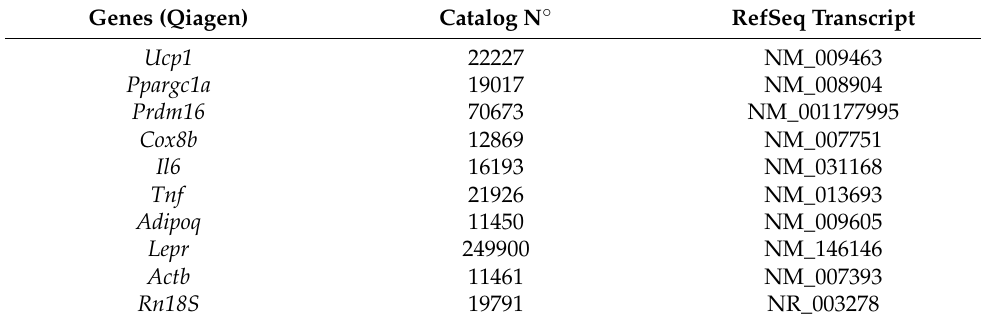
Table A1. Primers for Real-Time